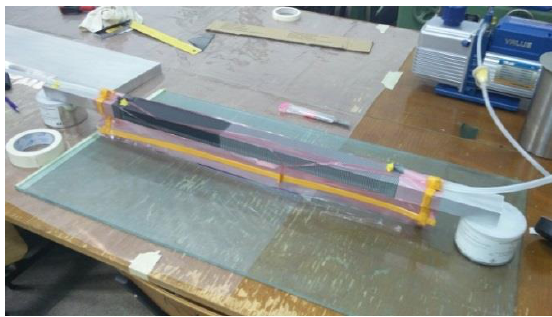
Fig. 3 Lower and upper panels VARTM assembly